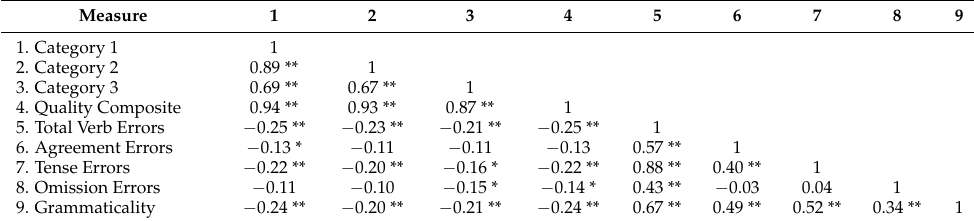
Table 6. Verb Errors and Writing Quality Correlations.